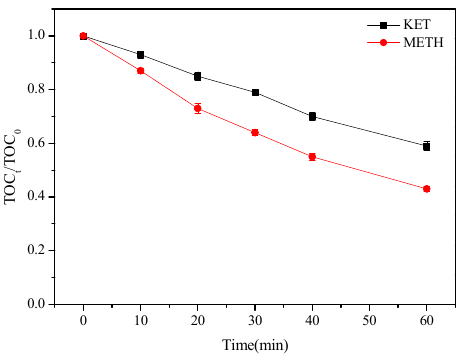
Figure 14. The mineralization of KET and METH during the UV/H 2 O 2 system. Conditions: (KET) 0 = (METH) 0 = 100 μg/L, (H 2 O 2 ) 0 = 500 μM, pH 0 = 7, T= 25 ± 1 °C.